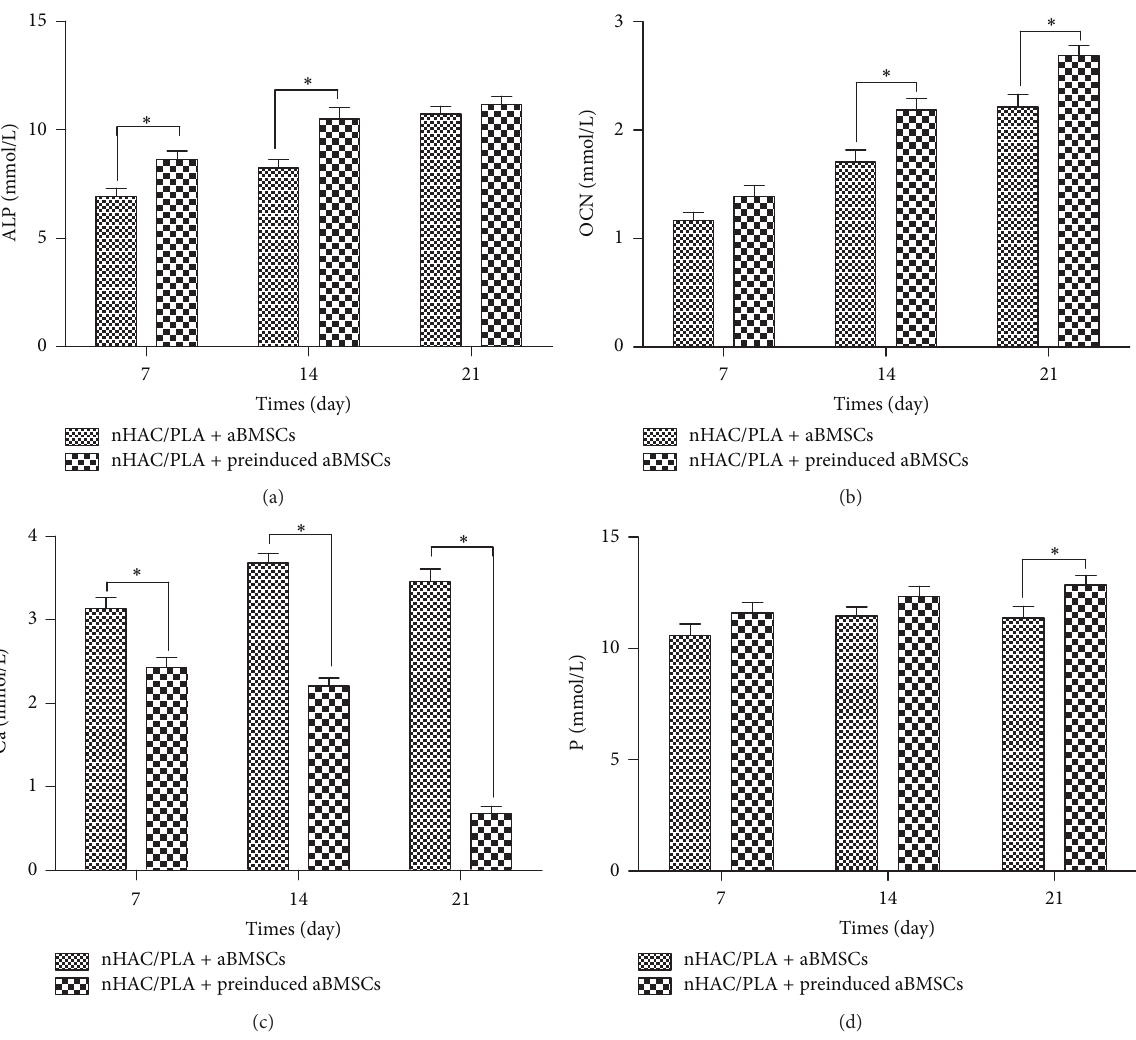
Figure 4: Effect of osteogenic induction on the ALP activity (a), OCN content (b), calcium content (c), and phosphonium content (d) of aBMSCs cultured on nHAC/PLA ( 𝑛 = 6 , mean ± SD). ∗ Compared with nHAC/PLA + aBMSCs. Differences are significant at 𝑝 < 0.05 .